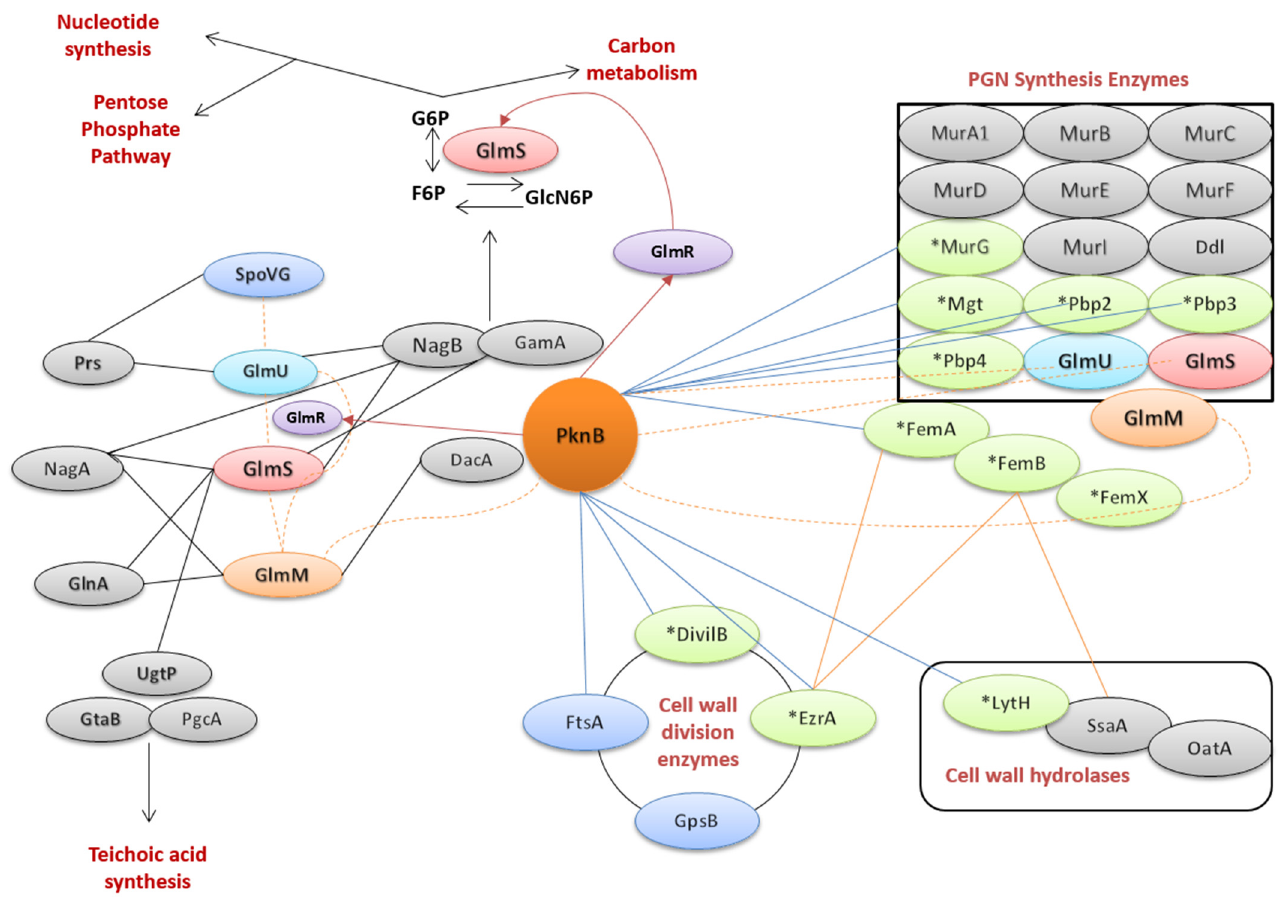
Figure 4. Interactome analysis of PknB protein. The PknB molecule interacts with the proteins involved in central carbon metabolism, nucleic acid synthesis pathways, pentose phosphate pathway, teichoic acid synthesis and the enzymes associated with peptidoglycan (PGN) synthesis. Shown are the different types of interactions: Experimentally verified substrate for phosphorylation by PknB, experimentally verified protein–protein interaction (including data from databases such as the STRING database) and metabolic interactions. Proteins interacting directly with PknB are shown with a blue arrow, and other interactions are indicated by a black arrow. GlmS, GlmU and GlmR proteins are involved in a chain of reactions that regulate central carbon metabolism by interacting with PknB (marked with a maroon arrow). The interactions of Fem proteins (FemA and FemB) are highlighted with an orange arrow. The doted lines indicate different substrates of PknB according to interactome analysis. In the protein interaction network, the central role played by GlmR in association with PknB (green) is shown. GlmR-GlmS-GlmU proteins participate in the cascade of reactions in response to the availability of a nutrient carbon source, thereby regulating different pathways, such as peptidoglycan biosynthesis. The proteins marked with an asterisk (*) are direct interaction partners by PknB substrate phosphorylation according to [11].